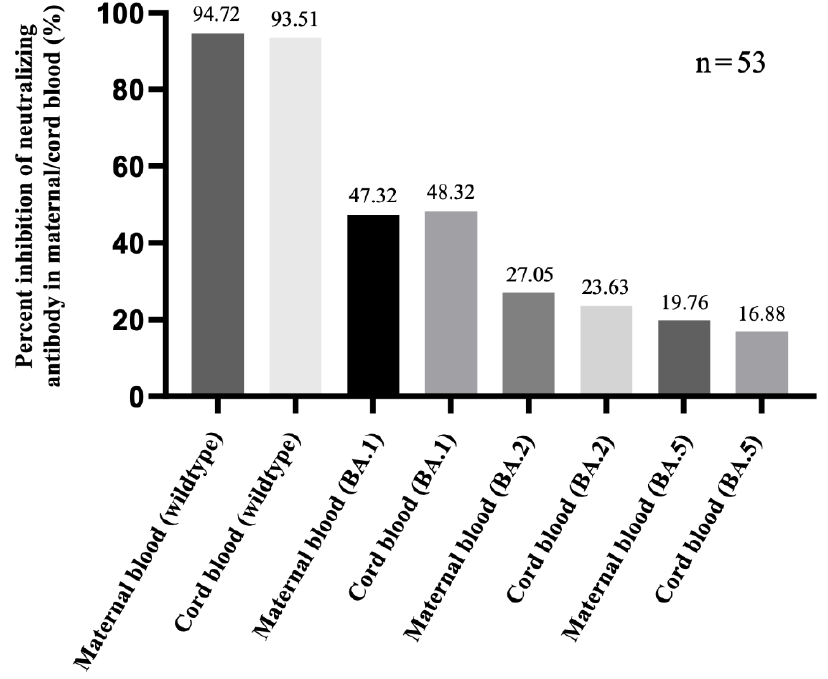
Figure 7. The inhibition of neutralizing antibody (%) against the Omicron sublineage in three-dose mRNA-1273 groups. The samples were tested 12 weeks after the last vaccination.